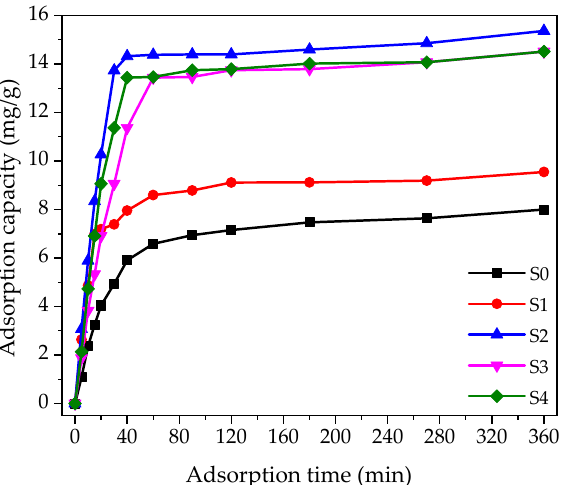
Figure 4. Kinetics of methylene blue (MB) adsorption onto gelatin and gelatin/ β -CD composite fiber adsorbents.